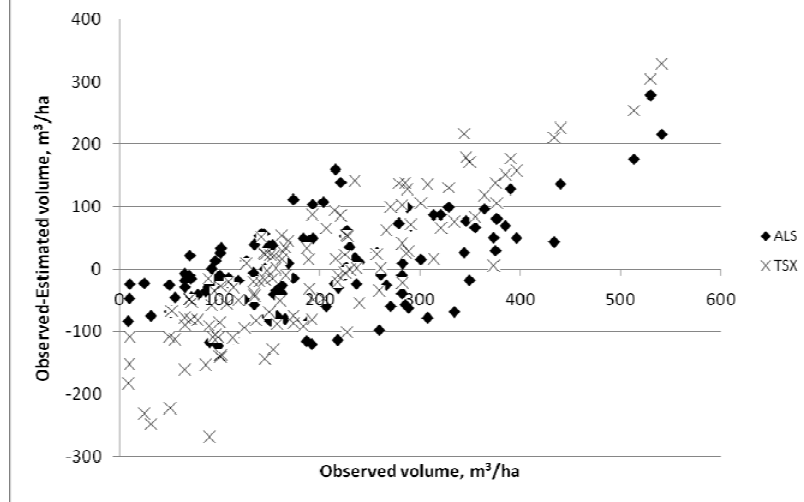
Figure 2. Volume estimation errors (Vol TerraSAR-X feature